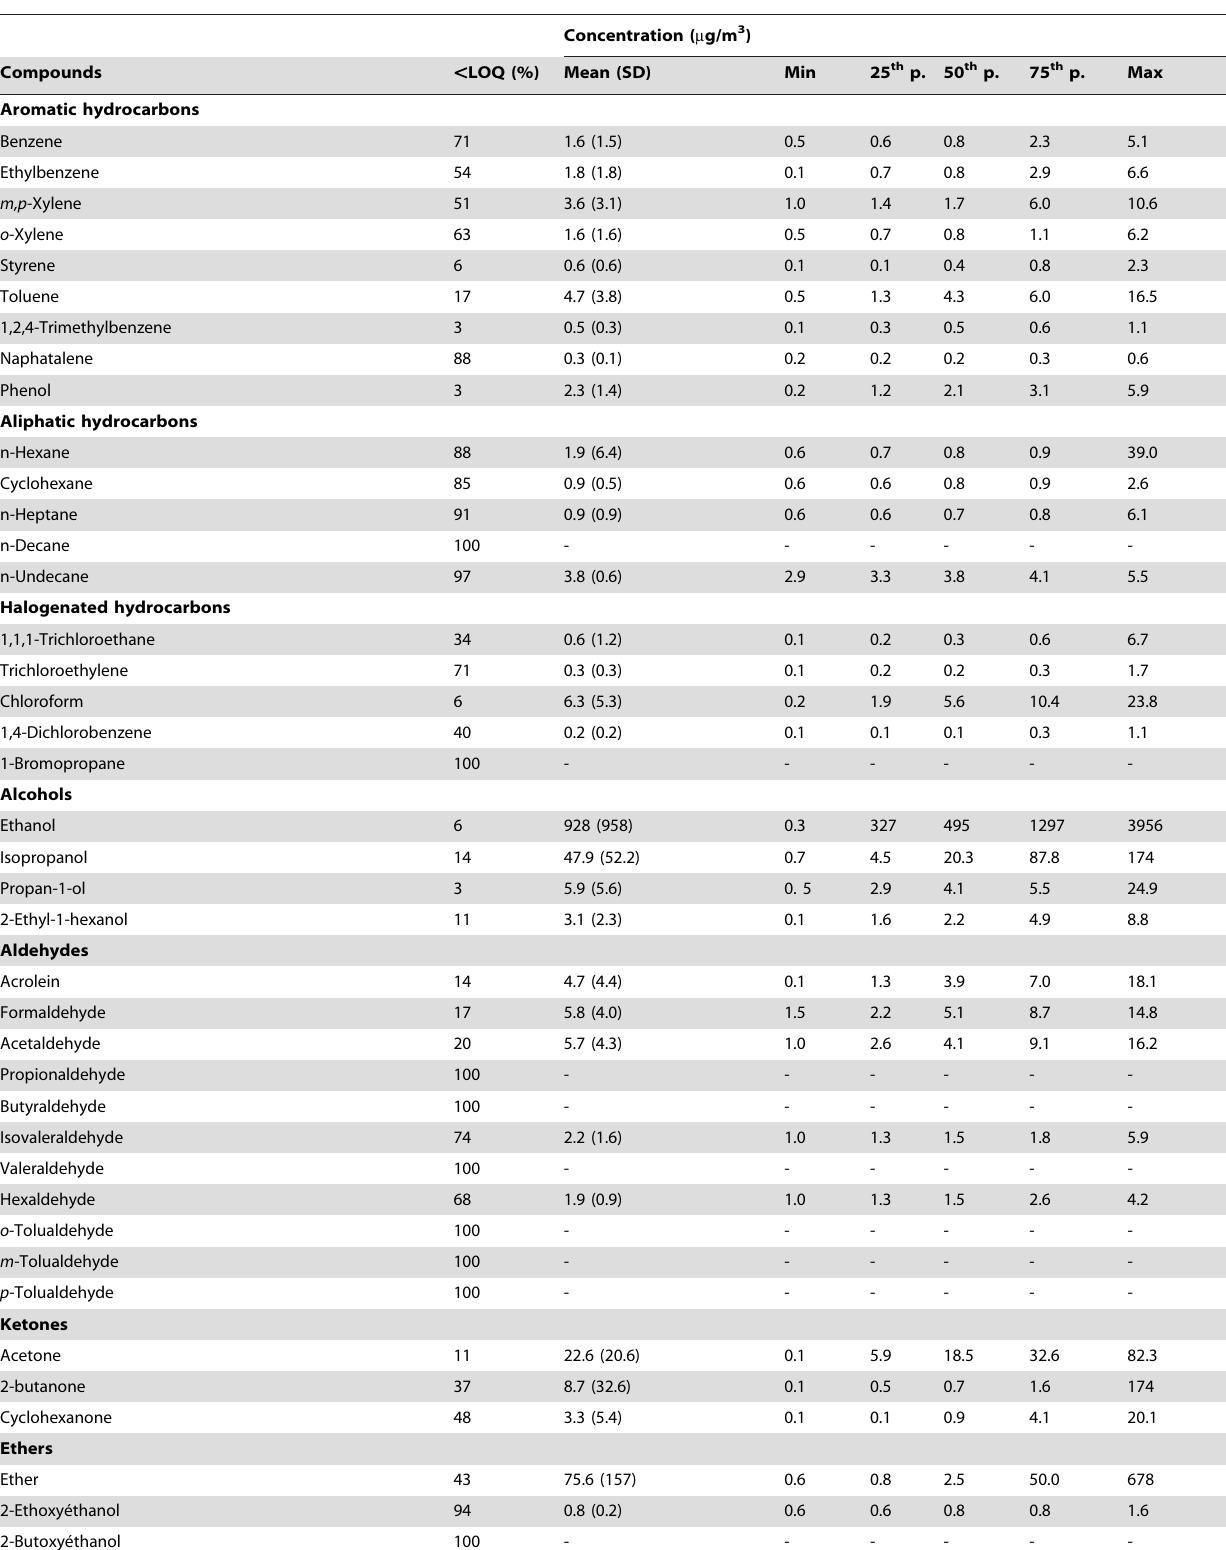
Table 4. Distribution (mean, standard deviation (SD), minimum, 25 th percentile, median, 75 th percentile and maximum) of indoor air concentrations of target compounds measured in all sites ( n =